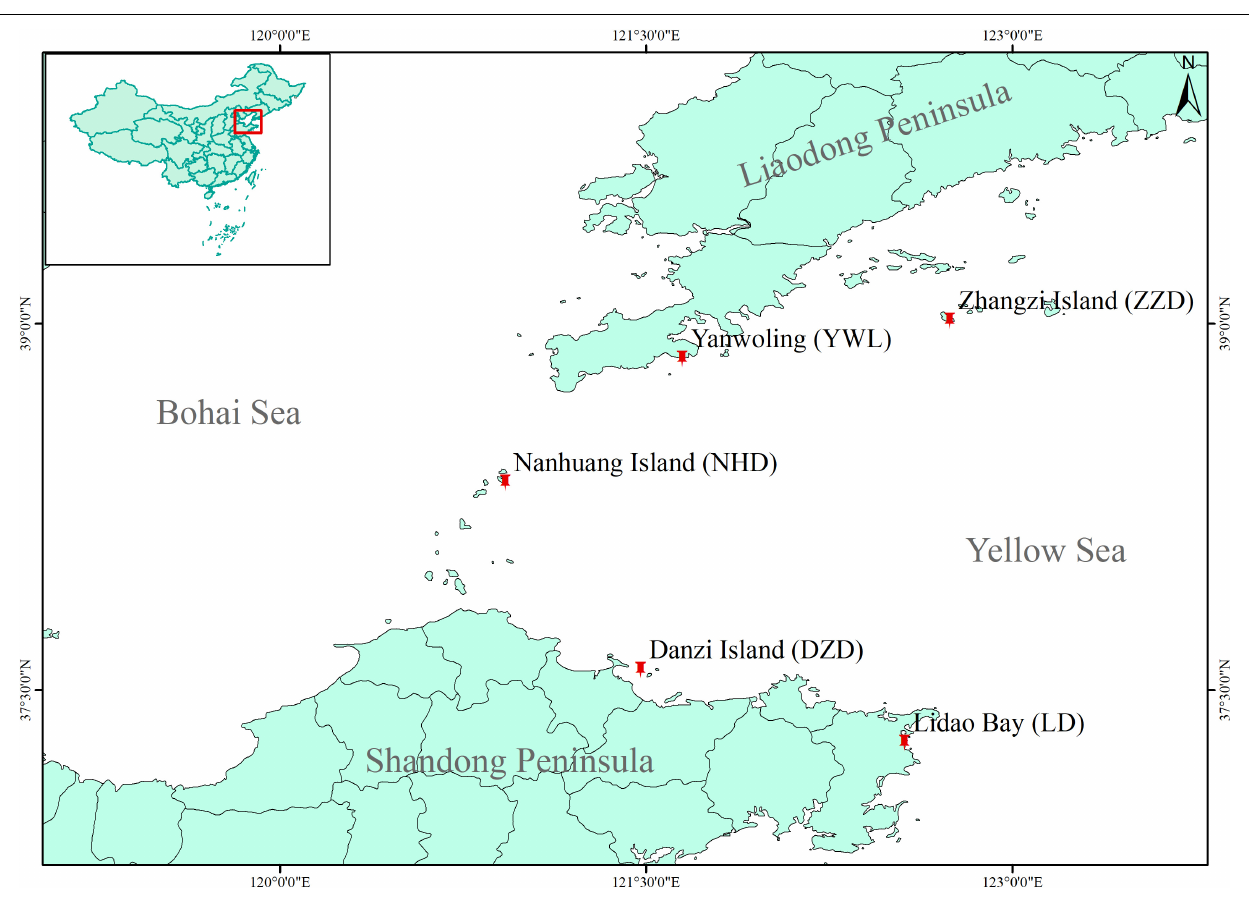
FIGURE 1 | Map for sample locations of Mesocentrotus nudus in